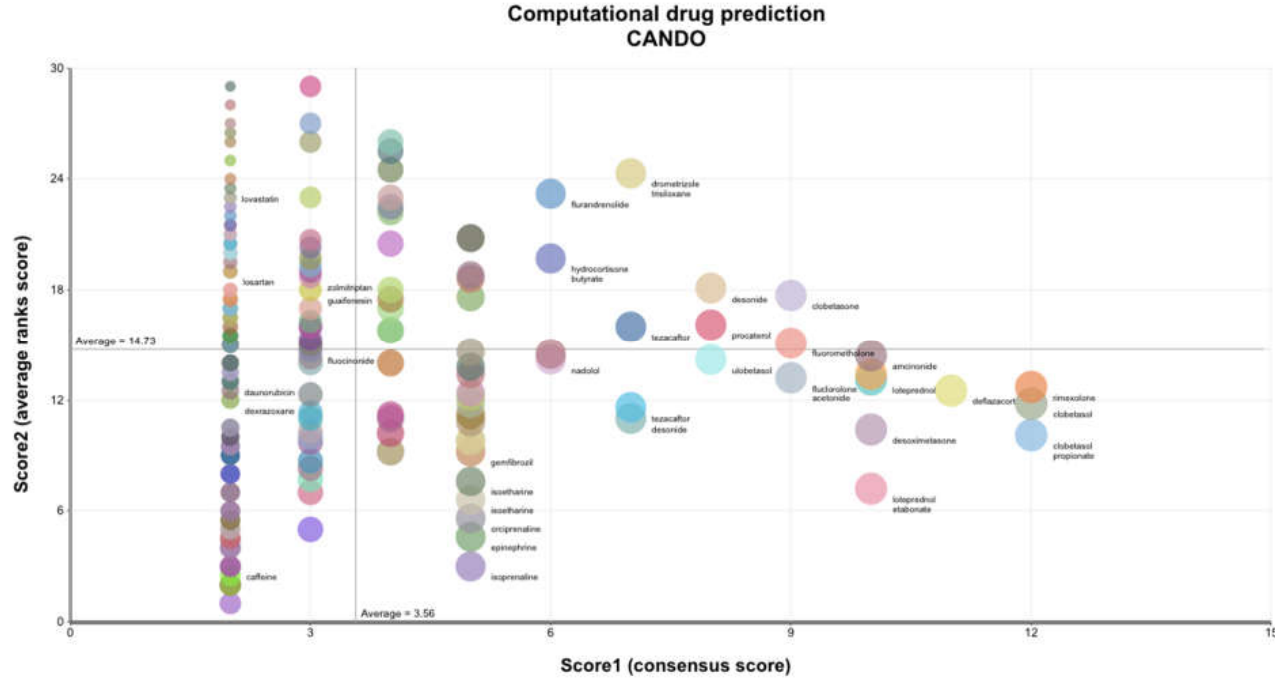
Figure 1. Putative drug candidates for treating COPD generated using the CANDO platform. A subset of 130 proteins from the CANDO human protein library was identified from 233 differentially expressed proteins in the BALF. These 130 proteins were utilized to generate BALF-specific interaction signatures for 2450 FDA-approved drugs via our in-house docking protocol BANDOCK (see methods). These drug–proteome interaction signatures were compared to 34 known drugs used to treat COPD to predict 189 of the most similar putative drug candidates. The 189 drugs are represented by colored circles, with the diameter of the circles decreasing with descending overall rank. Drug name labels are depicted for the selection of the 189 drugs shown by the colored circles. The horizontal axis plots the consensus score count or the number of times the particular drug is listed within the top 30 most similar drugs to those known to treat COPD based on interaction signature similarity. The vertical axis plots the average of the cumulative ranks of the consensus scores for the putative drug. The overall rank of a putative drug is determined by initially sorting the drug by the consensus score, as noted above, and then additional sorting by the average rank. Many of the drug candidates were corticosteroids not used to treat COPD; however, other putative drugs included tezacaftor, a drug to potentiate sodium channel activity in the treatment of cystic fibrosis; two additional drugs predicted to treat COPD, gemfibrozil, and pioglitazone, are drugs currently used to treat hyperlipidemia and diabetes, respectively. This analysis indicates that the CANDO platform applied to the BALF proteome can generate putative drug candidates for COPD treatment.